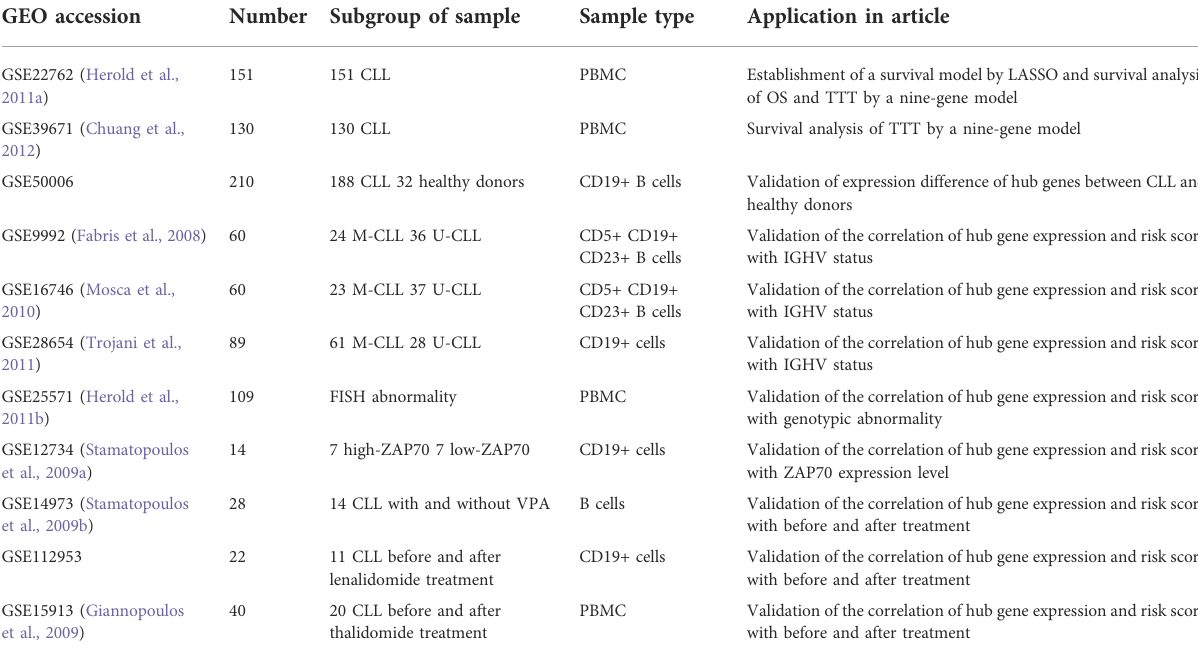
TABLE 1 Details of databases used in this research